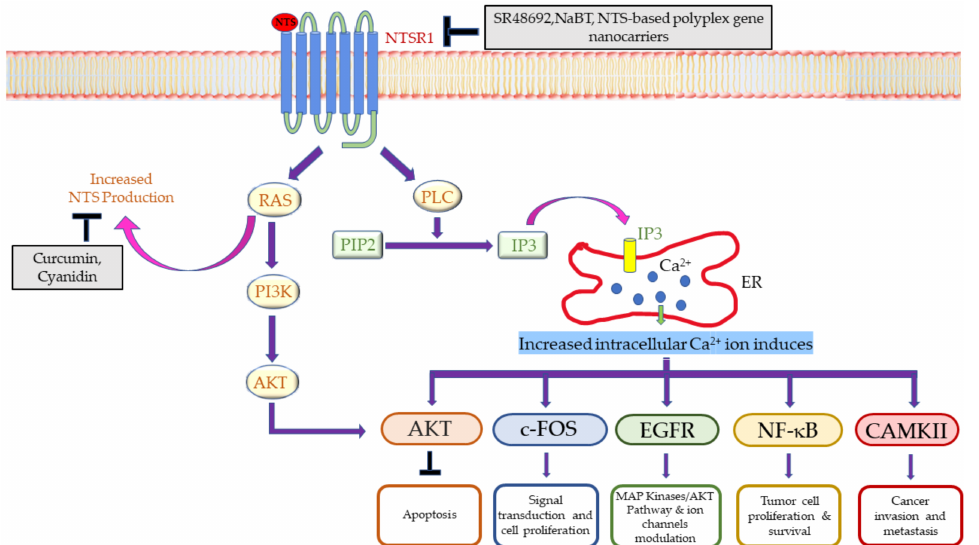
Figure 2. Signaling cascade driven by NTS interacting with NTSR1. This complex is involved in the gene regulation of various biological processes via activating the RAS-PI3K-AKT and PLC-IP3-Ca 2+ , finally contributing to cancer progression. Abbreviations: NTSR1: neurotensin receptor type 1; PI3K: phosphatidylinositol-3-kinase; PLC: protein lipase C; PIP2: phosphatidylinositol-4,5-bisphosphate; IP3: inositol trisphosphate; ER: endoplasmic reticulum; AKT, protein kinase B; EGFR: epidermal growth factor receptor; NF-kB: nuclear factor of kappa-light-chain-enhancer of activated B-cells; CAMKII: calcium/calmodulin-dependent protein kinase